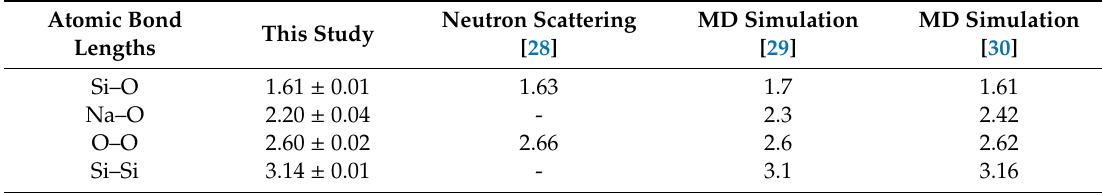
Table 1. Comparison of the atomic bond lengths of sodium disilicate glass derived from our experiment (Figure 9) with values from previous studies. The results agree well, demonstrating that our setup is capable of collecting reliable structure data of non-crystalline materials (unit: